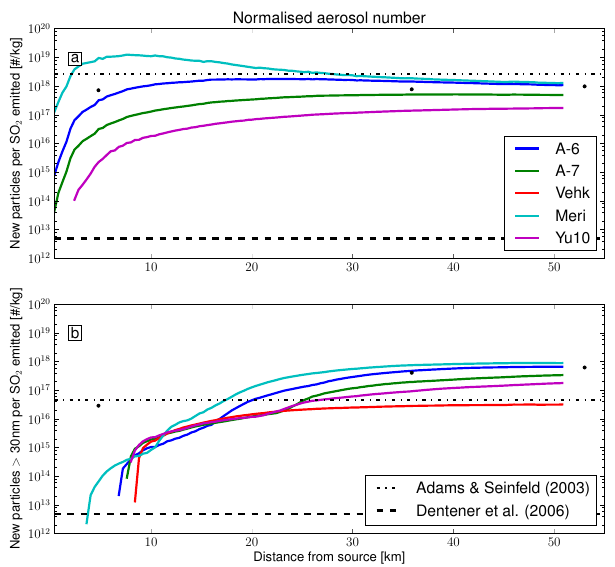
Fig. 8. (a) Total additional predicted particles and (b) additional particles larger than 30nmkg − 1 SO 2 versus distance from the Parish power-plant, using several nucleation schemes. See Sect. 3.1 for a description of the calculation. Values are averaged over the plume. Model resolution is 400 × 400 × 40m. Black dots indi- cate aircraft observations, solid colored lines indicate model re- sults, black dashed lines indicate the values used by Dentener et al. (2006), and black dashed-dotted lines indicate the values used by Adams and Seinfeld